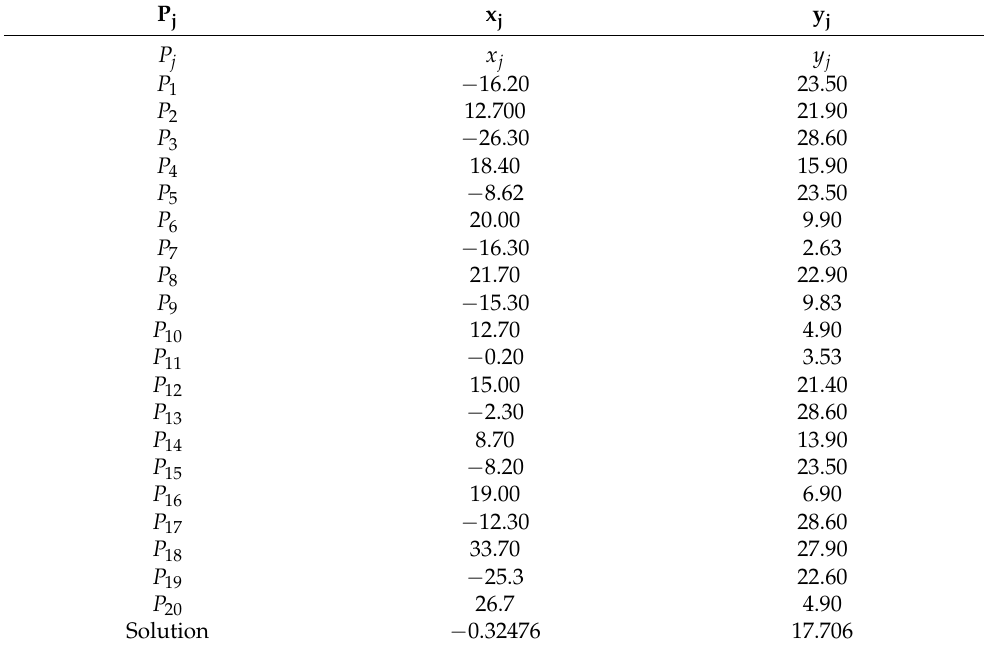
Table 3. F 1 = (25.00,18.00) and F 2 = ( − 25.00,12.00) are given with the equal weighted 20 points (Value is 1). The minimax value is 15.5322.